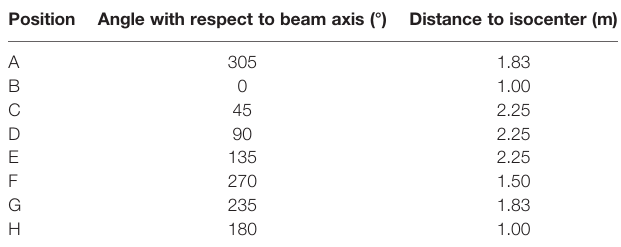
TABLE 3 | Eight measurement positions around the 1-, 5-, and 10-year-old pediatric phantoms. Position Angle with respect to beam axis (°) Distance to isocenter (m)